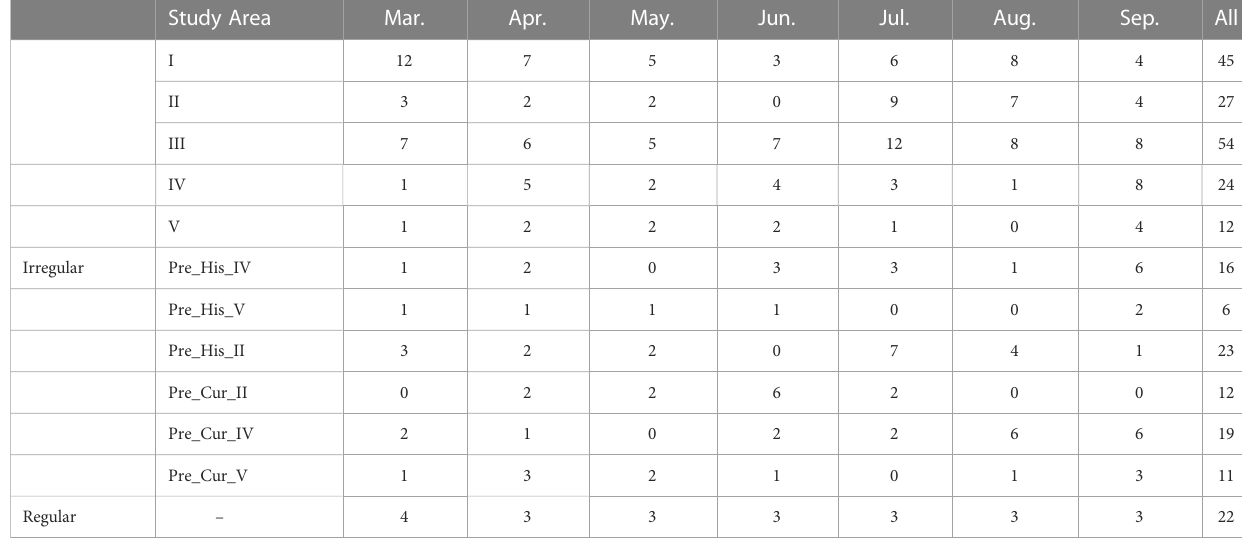
TABLE 1 Number of valid images in the fi ve study areas. Study